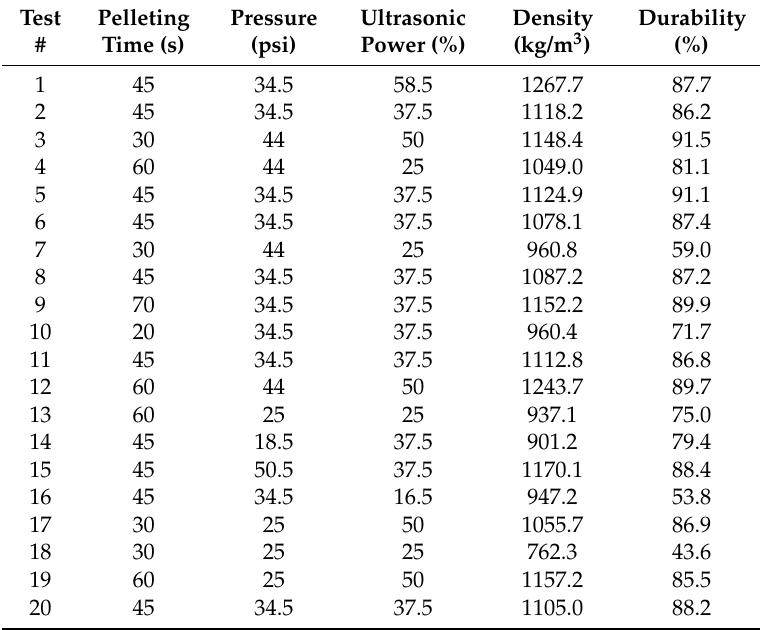
Table 1. The experimental results based on a central composite